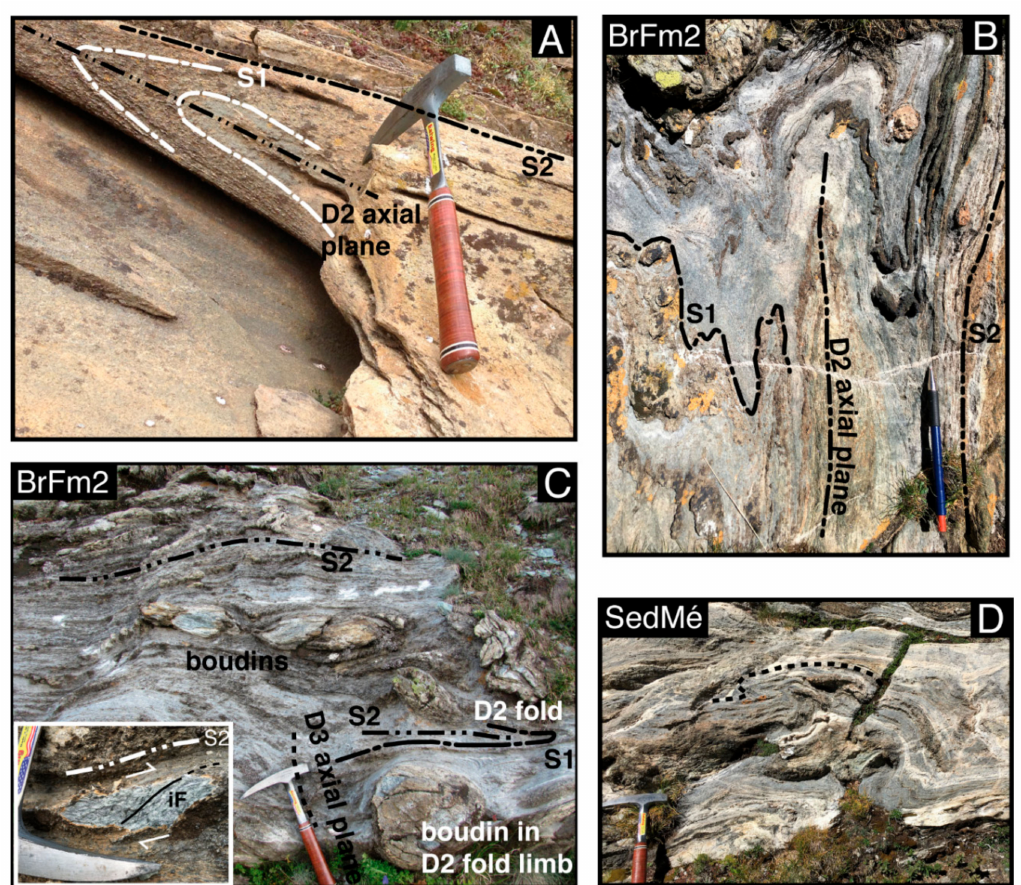
Figure 7. Structural features of the CCU. ( A ) Oldest Alpine foliation S 1 is observed in calcschists which marks the contact between metapelite and marble layers and is interpreted as the original bedding (S 0 ) of a flyschoid sequence. S 1 foliation has been folded by D 2 isoclinal folds, developing an S 2 axial planar foliation (i.e., the regional-scale main foliation). ( B ) Same S 1 -S 2 relations in BrFm2 (northeast of Lake Miserin). ( C ) D 2 phase folding the S 1 foliation in a block-in-matrix fabric (BrFm2). S 1 coincides with the ultramafic boudin / matrix contact and is folded by D 2 folds generating axial planar S 2 . D 2 folds have boudinated limbs (“boudins”) and are gently re-folded by D 3 phase. Inset: Internal foliation within ultramafic boudin is incorporated into the matrix foliation (S 2 ). ( D ) Superposed folds generating interference pattern of type 2 of [106] in a SedM é